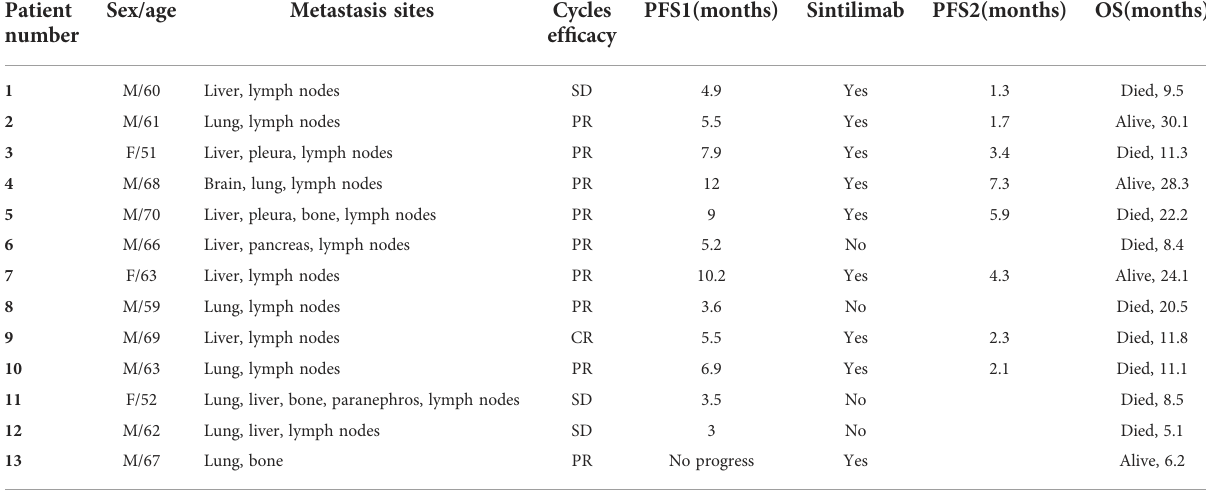
TABLE 1 Baseline characteristics of patients and the clinical ef fi cacy.